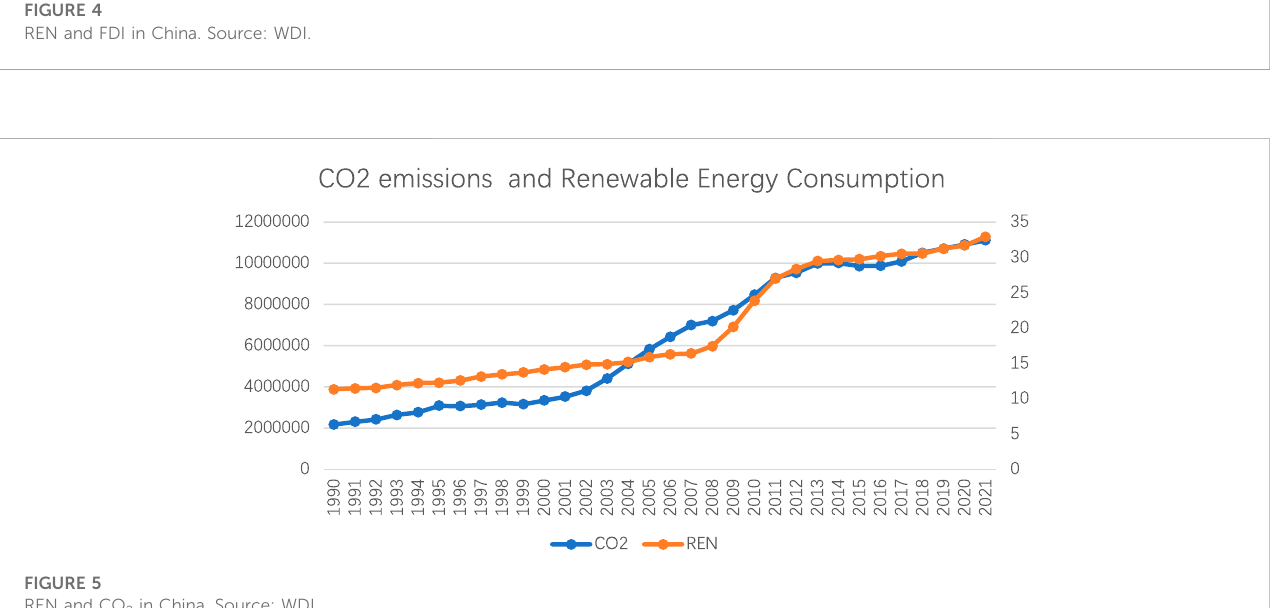
FIGURE 5 REN and CO 2 in China. Source: